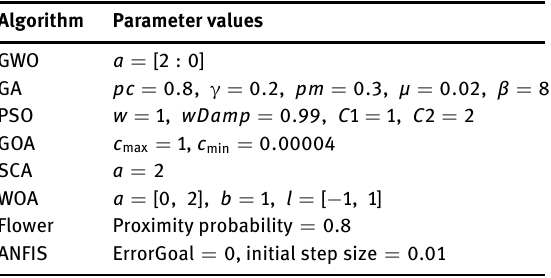
Table 4: Parameter Setting of the Algorithms.